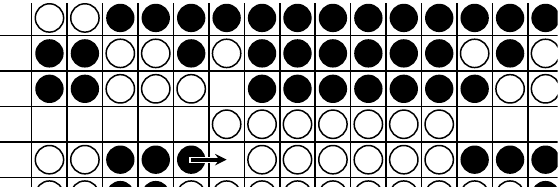
Figure 96. WHITE captures.